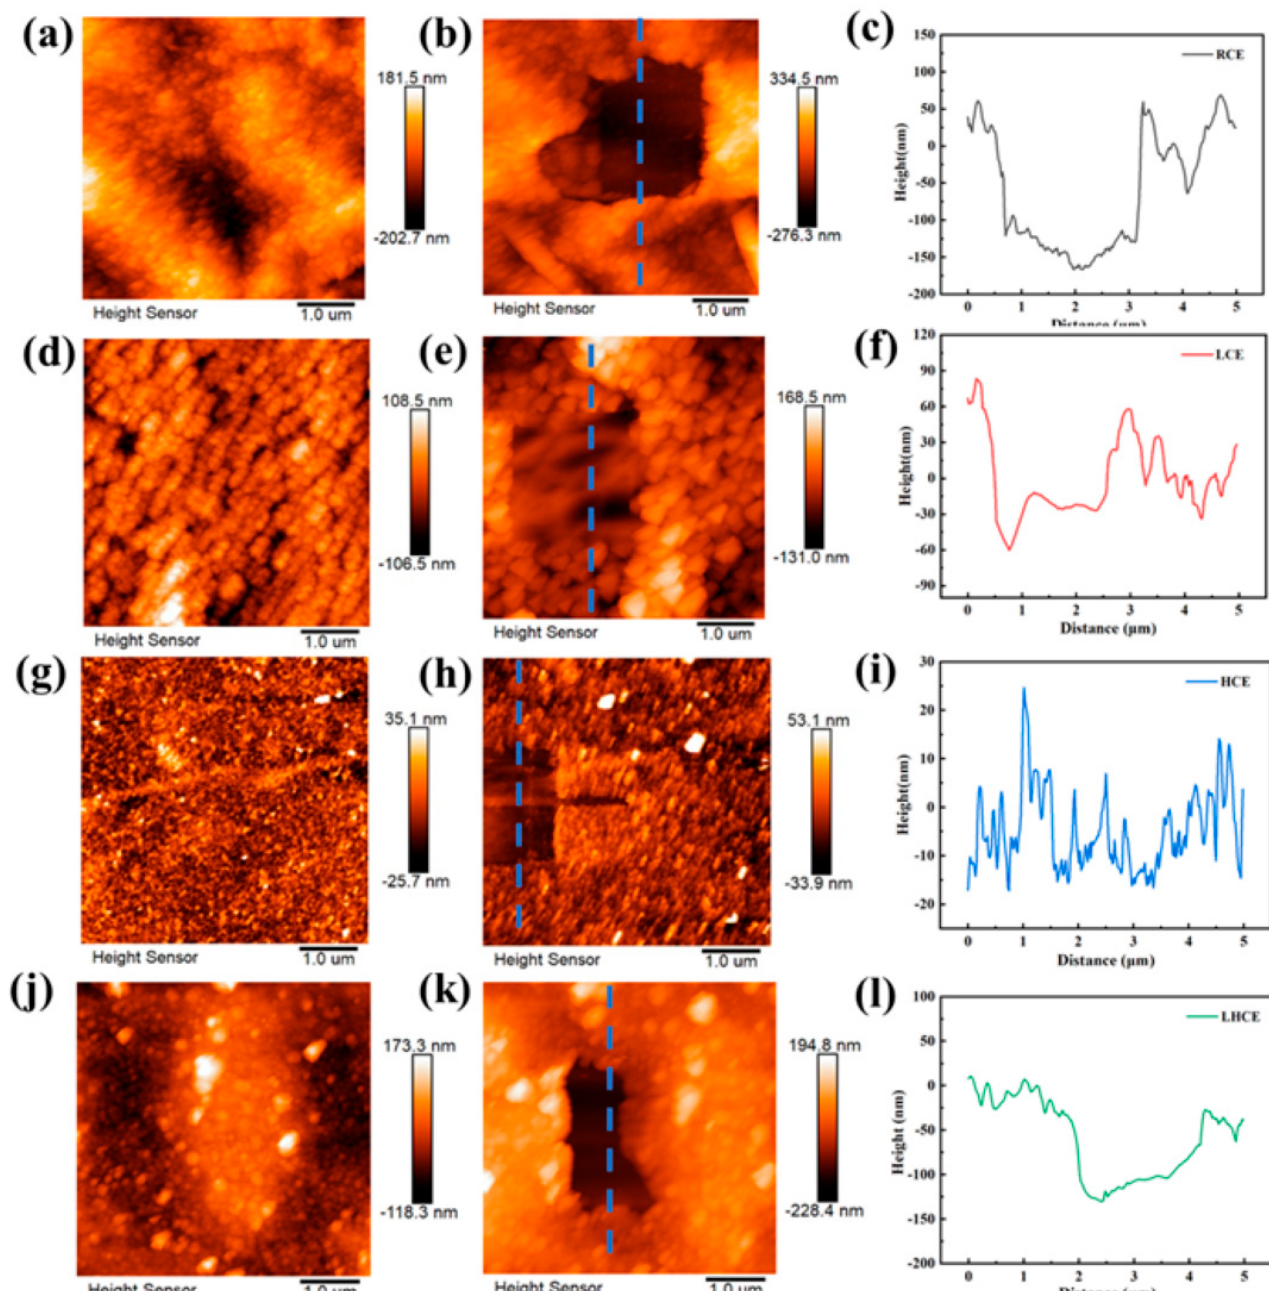
Figure 7. Thicknesses of SEI film formed under four electrolytes. SEI film morphology after CV cycling in ( a ) RCE, ( d ) LCE, ( g ) HCE, and ( j ) LHCE; SEI film morphology after AFM probe tip scraping: ( b ) RCE, ( e ) LCE, ( h ) HCE, and ( k ) LHCE; and thickness profiles of the corresponding regions: ( c ) RCE, ( f ) LCE, ( i ) HCE, and ( l ) LHCE.